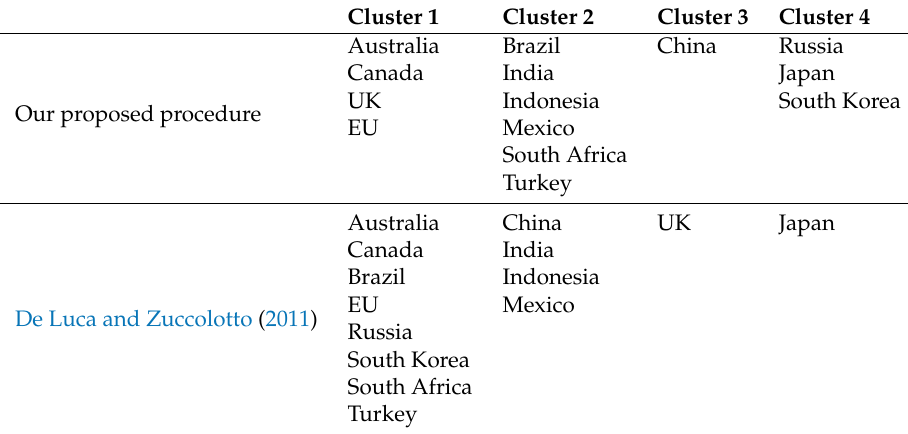
Table 7. Members for each of the clusters when k =